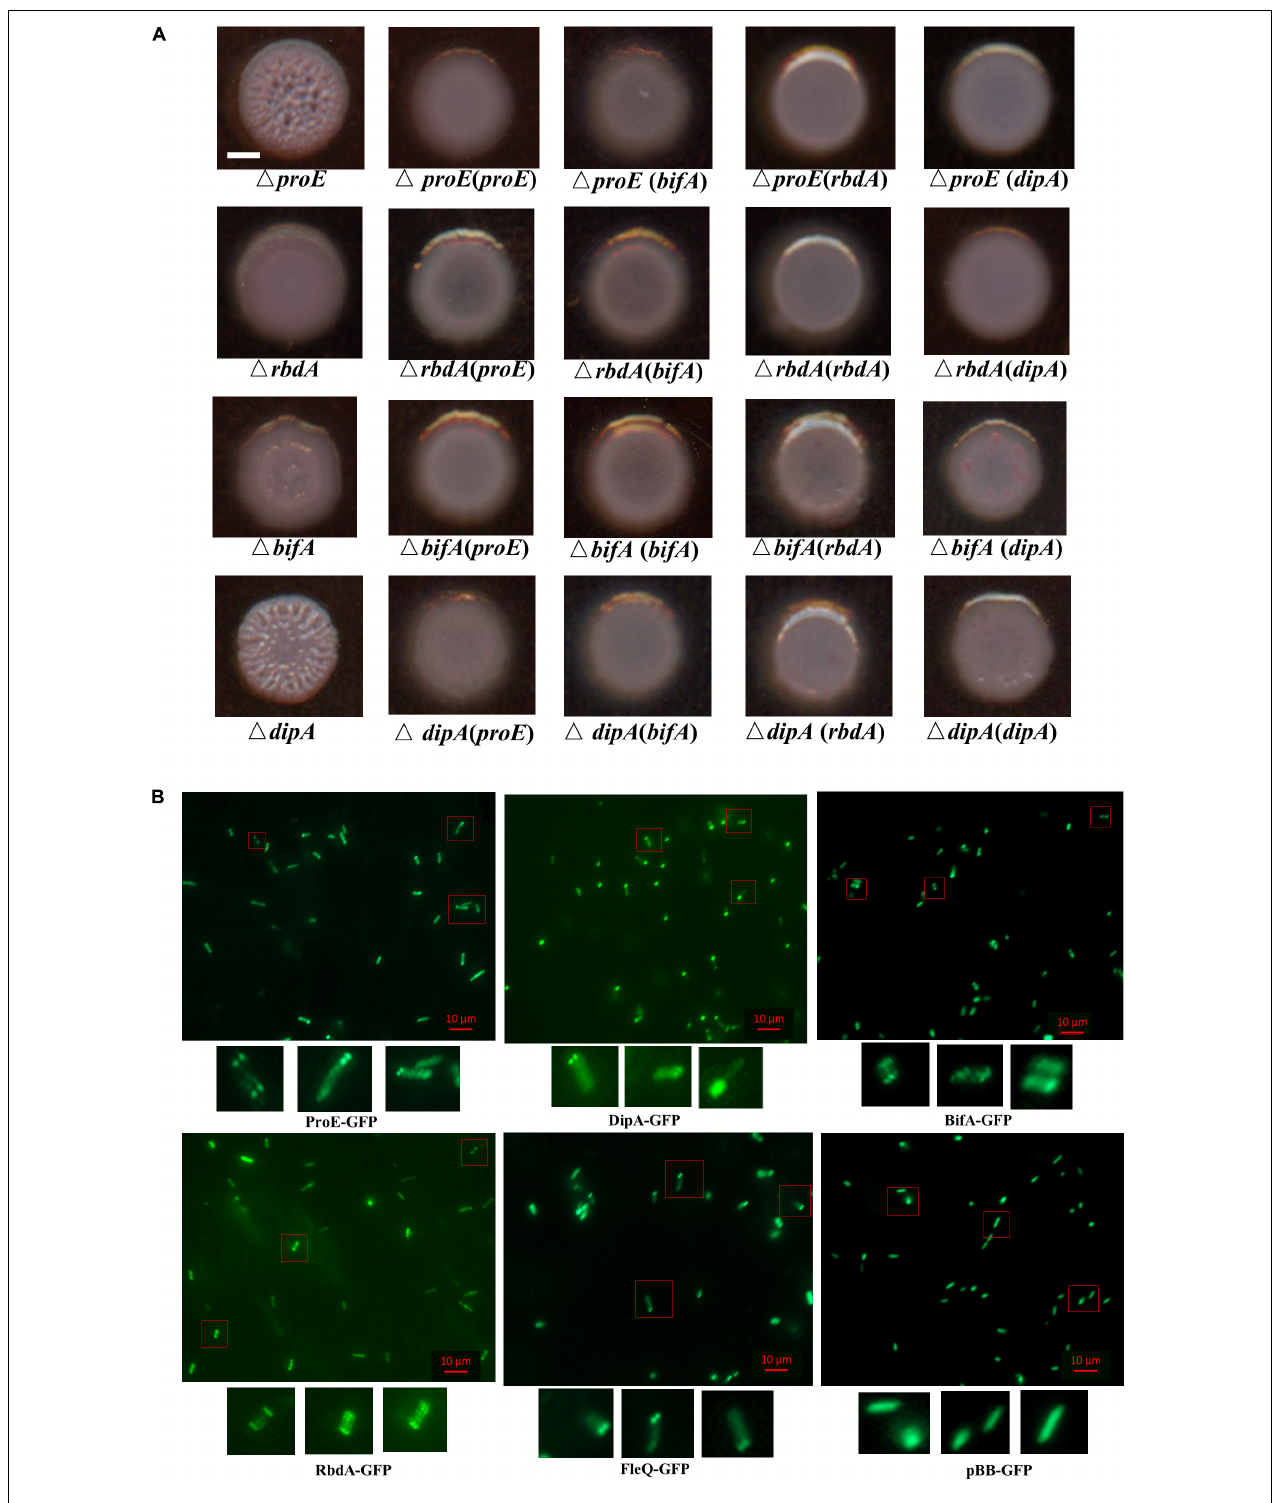
FIGURE 8 | Functional and subcellular localization analysis of EPS-associated phosphodiesterases. (A) ProE and other three phosphodiesterases synergically regulated the colony morphology in P. aeruginosa . Deletion of either proE , rbdA , bifA or dipA can cause wrinkly morphology at different extent, and the functional defect can be restored by each other. Scale bar = 2 mm. (B) Subcellular localization of GFP fusion proteins. Bacterial colonies expressing indicated GFP fusion proteins were picked from overnight LB agar plates, resuspended in PBS and 2 µ l culture was spotted onto a glass slide coated with 1% agarose. Images were taken by using epifluorescent microscopy. Scale bar = 10 µ